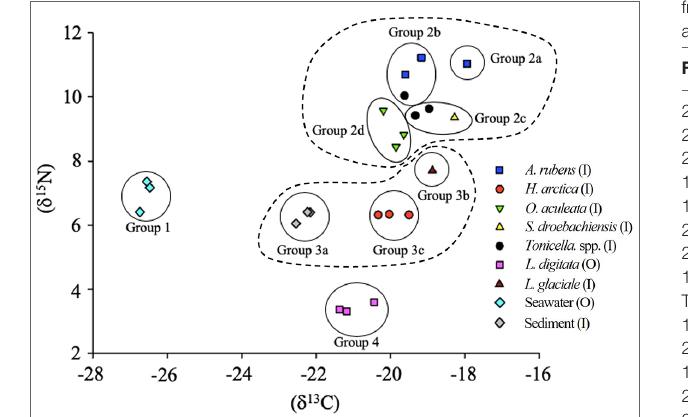
TABLE 5 | Trophic multiplication factor (TMF) of 37 fatty acids (FA) as calculated from the slope (m) of corresponding linear relationship between FA concentration and bulk nitrogen ( δ 15 N) stable isotope ratio (see section 2.8).